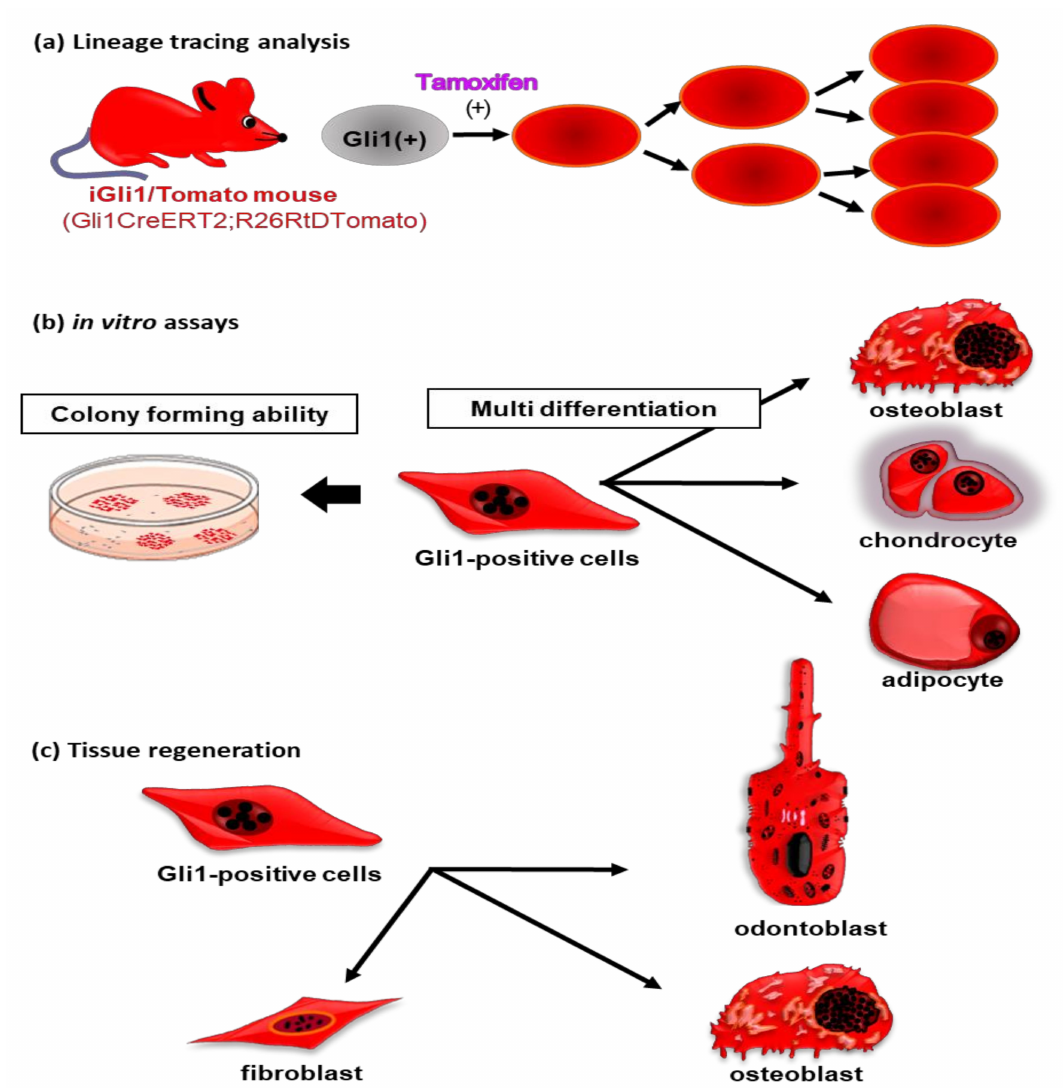
Figure 2. Schematic illustrations of characteristics of Gli1-positive cells in mature teeth. ( a ) After tamoxifen administration in iGli1 / Tomato mice, Gli1-positive cells are shown to express Tomato red fluorescence. Cells that once expressed Tomato red fluorescence continuously emit this fluorescence evenaftercelldivision. Usingthissystem, itispossibletotracethedi ff erentiationprocessofGli1-positive cells and their progeny cells. ( b ) Gli1-positive cells exhibit high colony-forming unit fibroblast (CFU-F) activity. These cells also have trilineage potential to form osteoblasts, chondrocytes, and adipocytes in vitro. ( c ) After tooth transplantation into subcutaneous tissue, Gli1-positive cells di ff erentiate into odontoblasts, osteoblasts, and fibroblasts during tissue